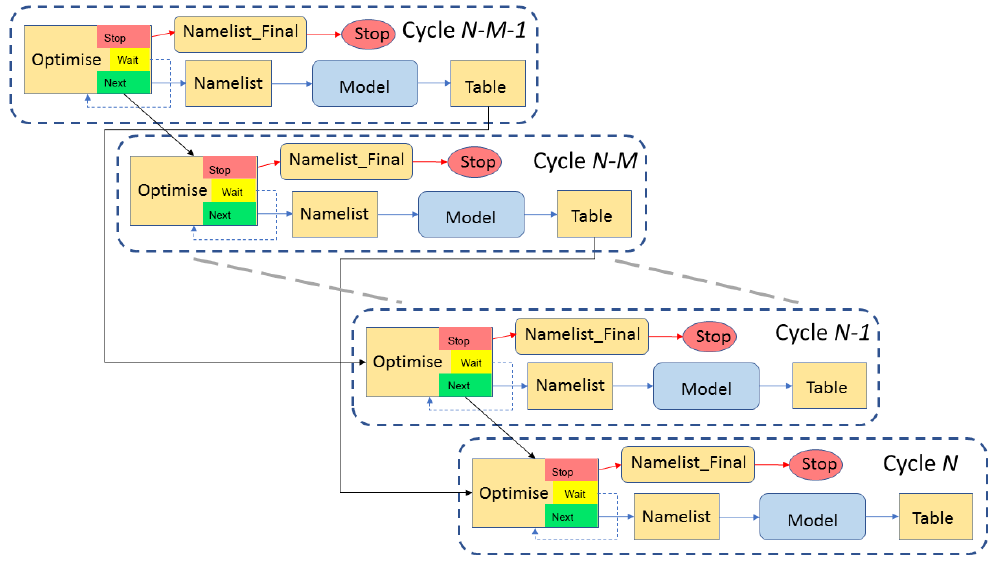
Figure 2. Dependency graph for an implementation of the Cyclops optimisation suite in which up to M concurrent simulations are supported. Solid arrows represent dependency, in that a task at the head of an arrow depends on the task at the tail of the arrow meeting a specified condition (by default, this means completing successfully) before it can start. The dashed arrows represent a task retrying after a set interval. Only four cycles are shown, omitting tasks in intervening cycles and their dependencies.